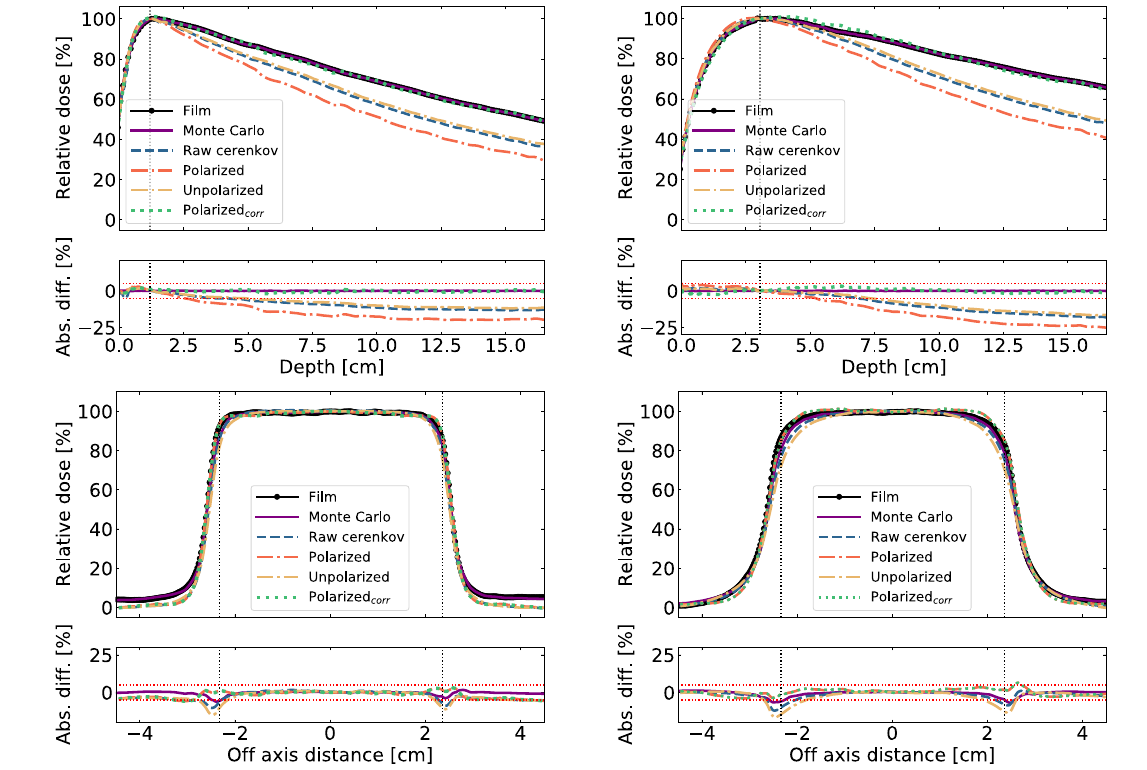
Figure 3. Photon beams projected percent depth dose (top) and profiles (bottom) sum over the thickness of the water tank and compared with dose measured from radiochromic films. Monte Carlo results are also presented for comparison. Vertical dotted lines indicate the position of maximum dose, while horizontal red dotted lines indicate a ± 5 % difference region. Left and right figures respectively present results from 6 MV and 18 MV